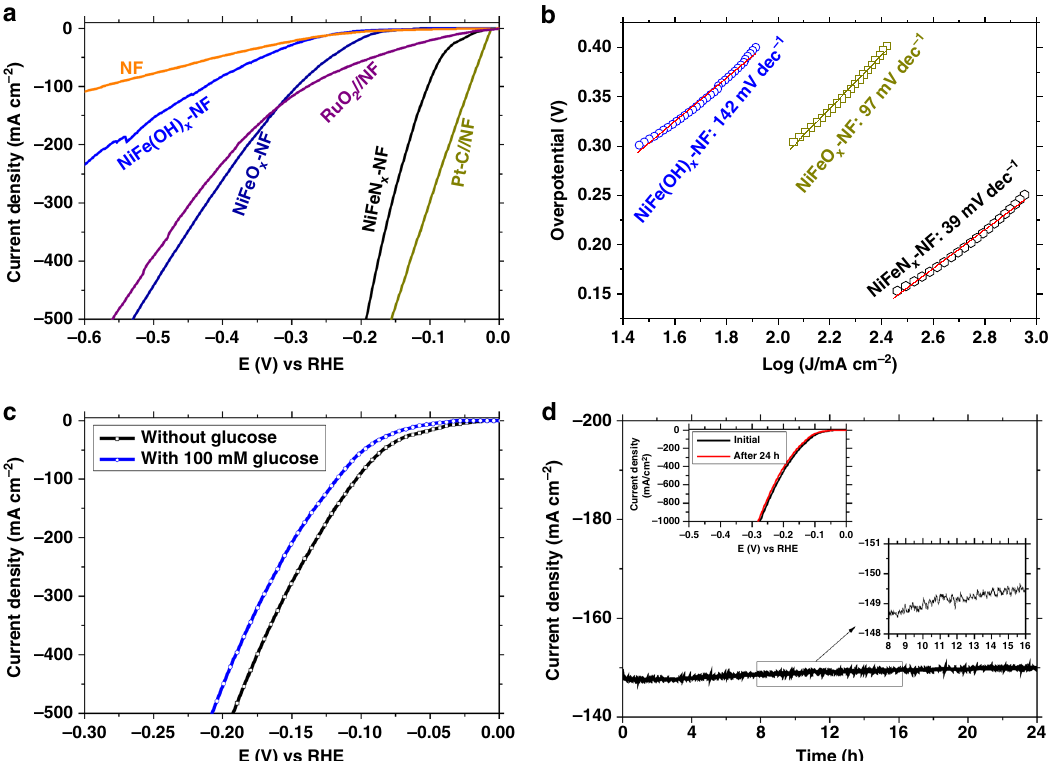
Fig. 7 Cathodic HER of the catalyst. a LSV pro fi les of the different electrodes for HER in 1 M KOH electrolyte (scan rate of 5 mV s − 1 ). b Corresponding Tafel plots. c Comparison of LSV pro fi les of the NiFeN x -NF catalyst for HER with and without 100 mM of glucose. d Chronoamperometric test of the NiFeN x -NF catalysts for HER with 100 mM of glucose, left inset: LSV pro fi les of the NiFeN x -NF catalysts before and after 24-h chronoamperometric test, right inset: ampli fi ed region of the chronoamperometric